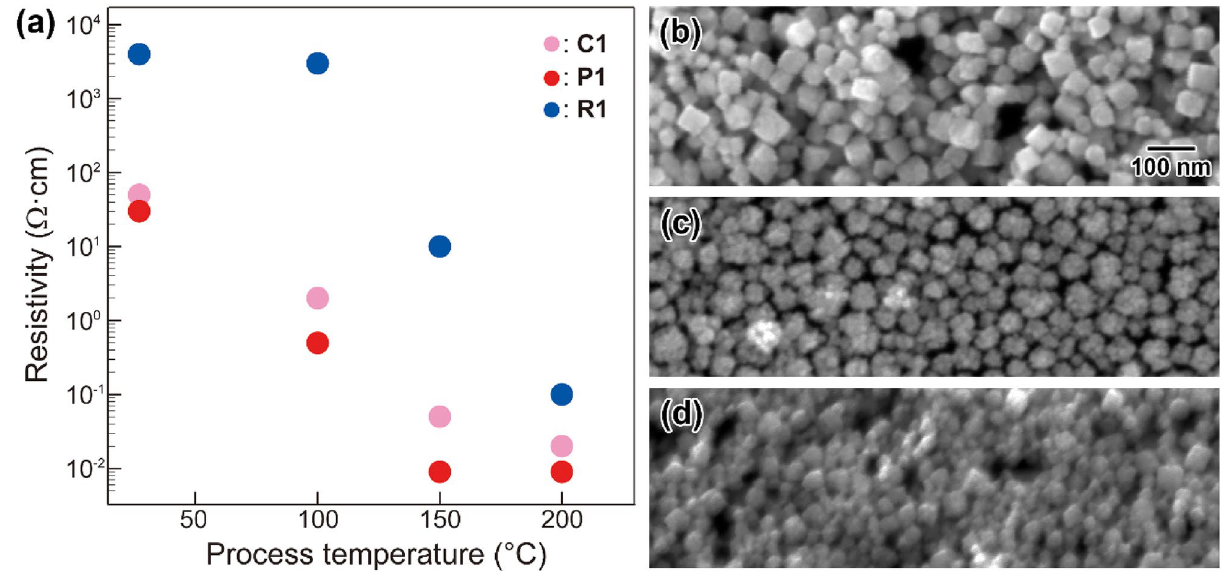
Figure 5. ( a ) Resistivity of the C1 -, P1 -, and R1 -based thin films on glass substrates obtained by NP-mist deposition in a low process temperature range from room temperature to 200 °C. SEM images of the surfaces of the ( b ) C1 -, ( c ) P1 -, and ( d ) R1 -based ITO thin films prepared by the NP-mist deposition method after annealed at 150 °C. The scale bar shown in ( b ) is common to ( c ) and ( d